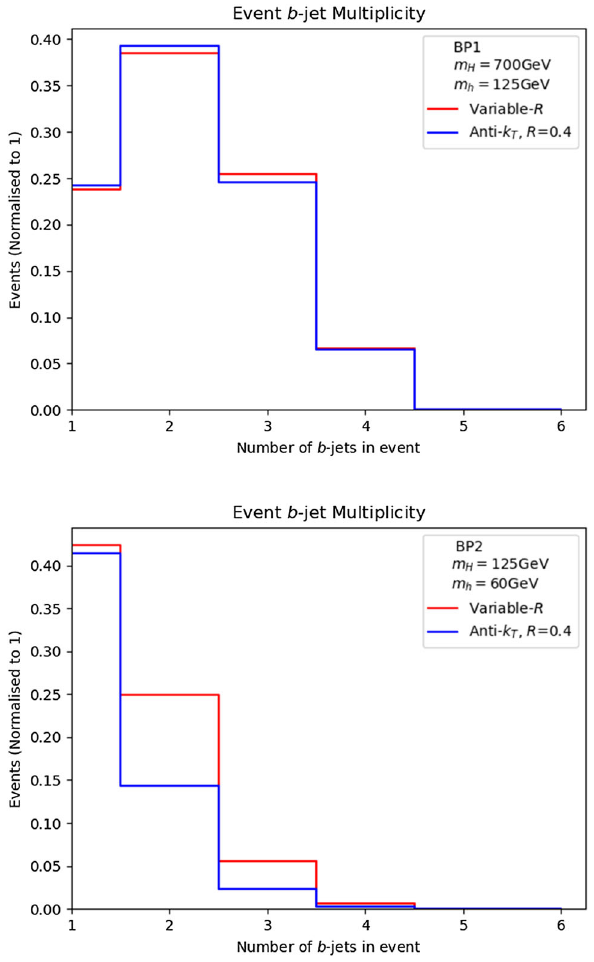
Fig. 9 The four b -jet invariant mass m h distributions from dijets for BP1 (upper panel) and BP2 (lower panel). The peak of the mass distri- bution obtained from the variable R algorithm is closer to the MC truth value of the corresponding